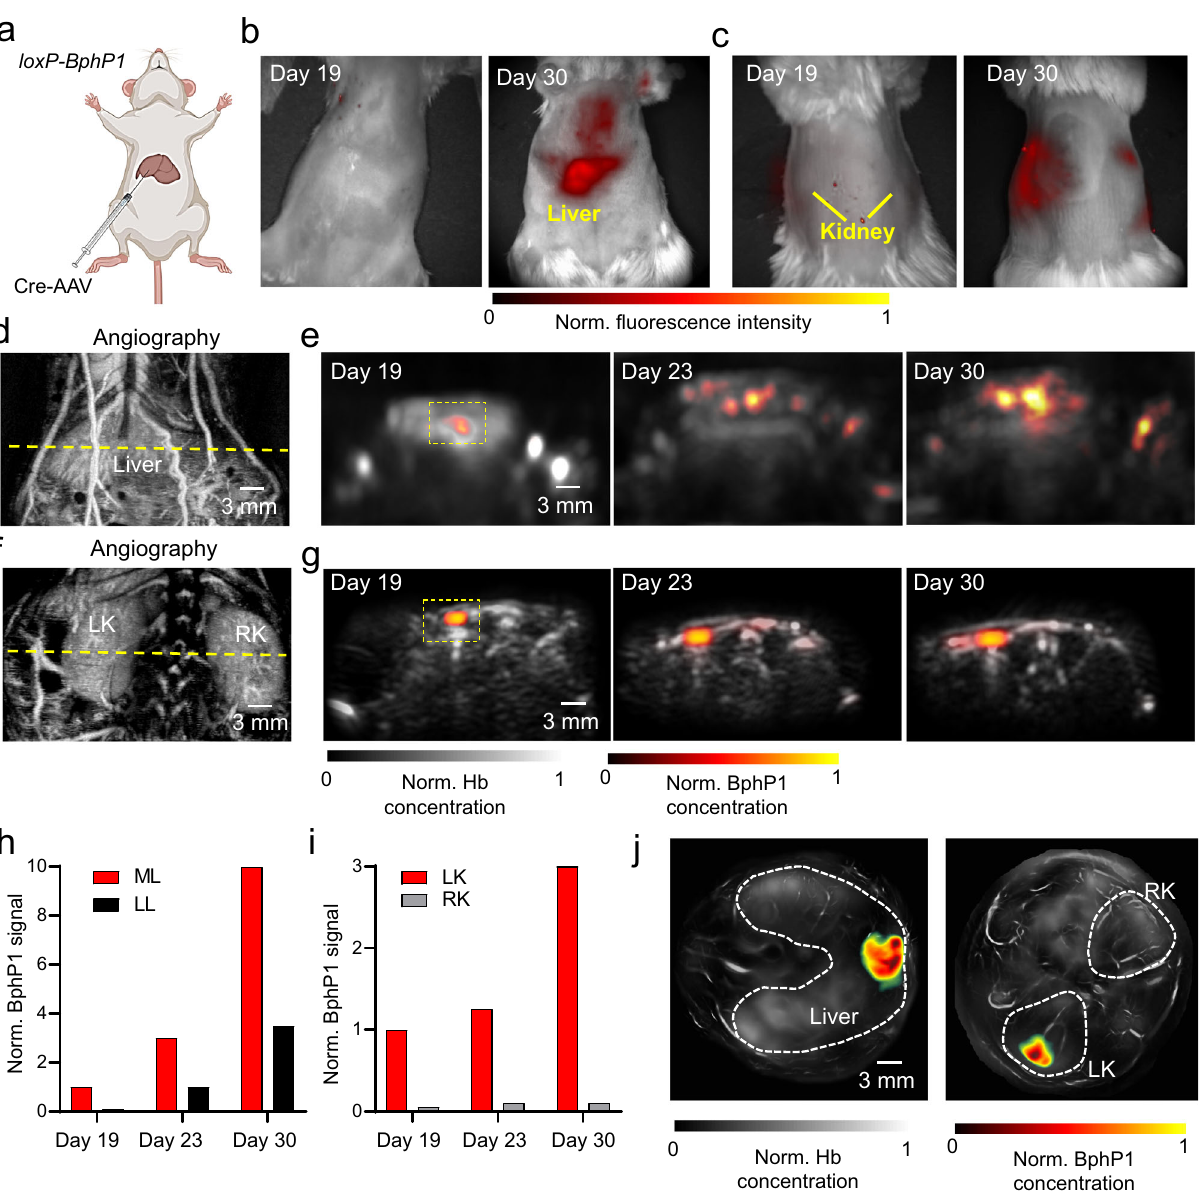
Fig. 7 Longitudinal PA imaging of the viral-mediated Cre-dependent speci fi c expression of BphP1 in vivo. a Cre-expressing AAVs was injected into the median liver lobe (AAV8) or a left kidney (AAV2) of the loxP-BphP1 mouse. b , c IVIS images of the mouse after the AAV injection into the liver ( b ) and left kidney ( c ), showing the BphP1 expression on Day 30. d Acoustic angiography image of the mouse liver region, acquired by the dual-modality ultrasound and PA imaging system. The dashed line marks the approximate region monitored by longitudinal PA imaging. e PA images of the BphP1 signals (shown in color) in the mouse liver at days 19, 23 and 30 after the AAV injection, acquired by the dual-modality system. The background hemoglobin signals were shown in grey. f Acoustic angiography image of the mouse kidney region. The dashed line marks the region monitored by PA imaging. g PA images of the BphP1 signals (shown in color) in the mouse left kidney at days 19, 23, and 30 after the AAV injection. There was no BphP1 expression observed in the right kidney. h Quantitative analysis of the mean BphP1 signals in the liver at different time points, as indicated by the dashed boxes in ( e ). ML, median lobe; LL, left lobe. The mean is the averaged pixel value in the dashed box. i Quantitative analysis of the mean BphP1 signals in the kidneys at different time points, as indicated by the dashed boxes in ( e ). LK, left kidney; RK, right kidney. The mean is the averaged pixel value in the dashed box. For h , i n = 2 biological replicates). j PA images of the BphP1 signals (shown in color) around the liver and kidney region of the same mice, acquired by the ring-array-based PA imaging system. The background hemoglobin signals are shown in grey. Source data are provided as a Source Data fi